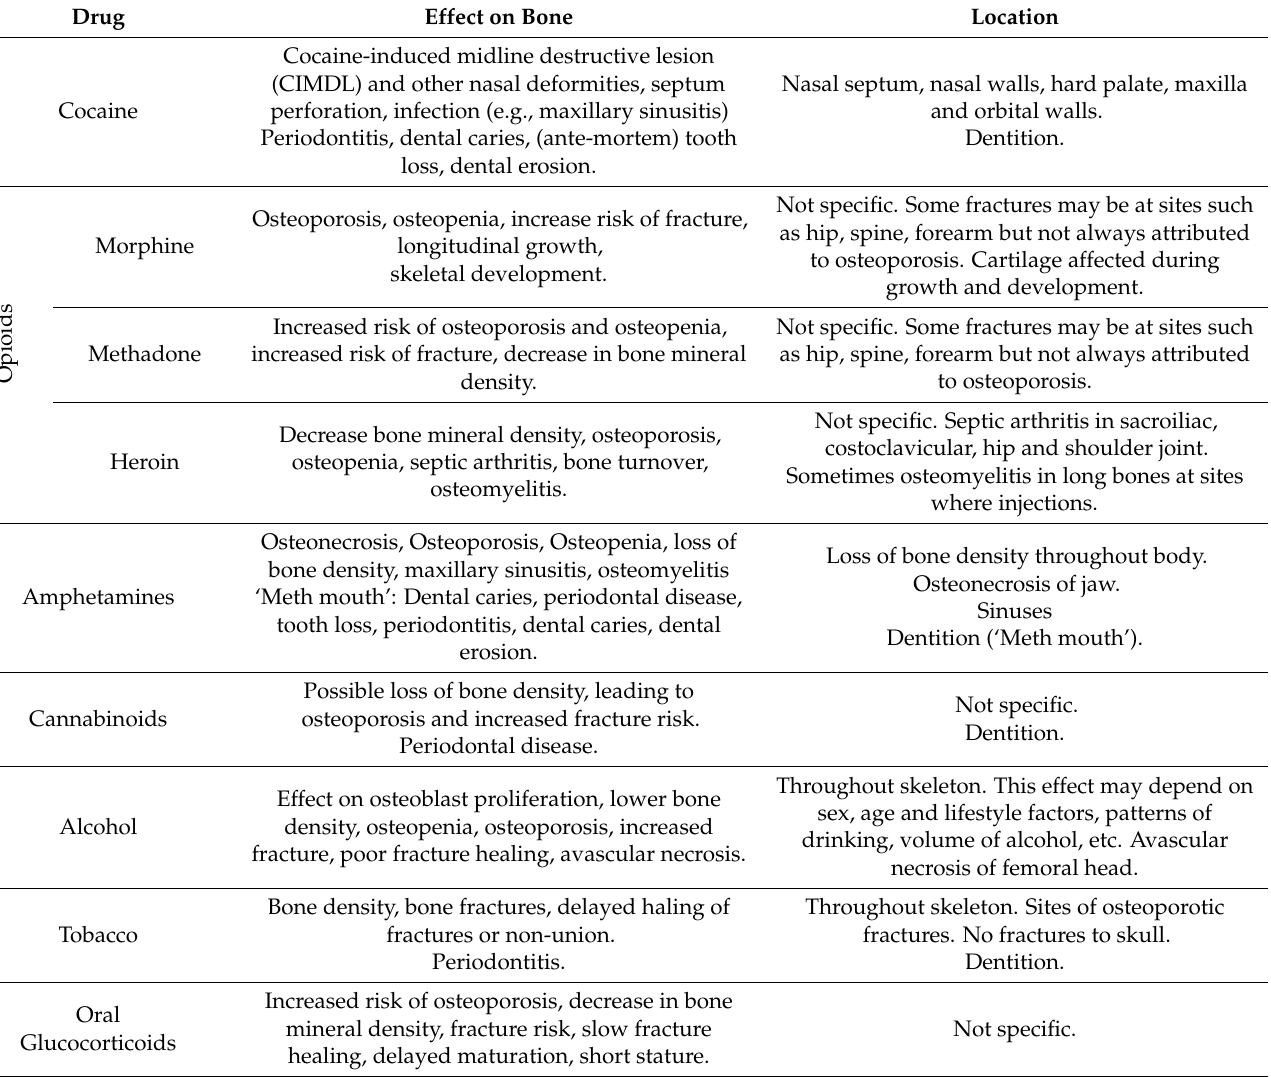
Table 1. Summary of the effects of drugs on bone, as taken from the literature review for this paper. For references or bibliography, see the main body of